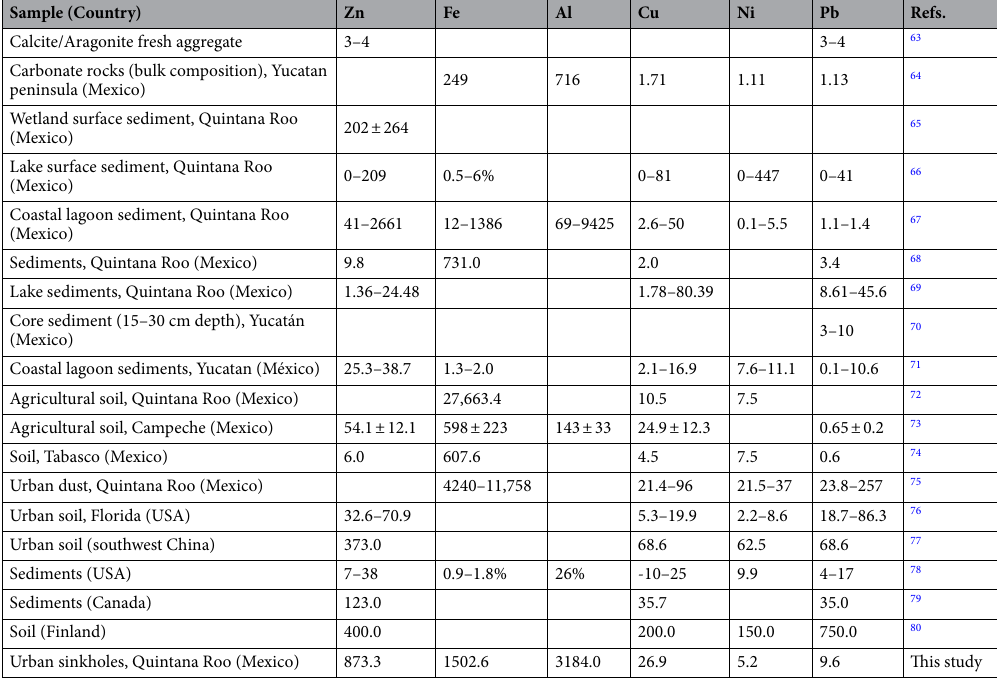
Table 5. Metal concentrations (mg/kg dry weight) in rocks, sediments, soils and urban dust in cities in southeastern Mexico and comparison with international standards. Values represent the average (± standard deviation) or range of reported